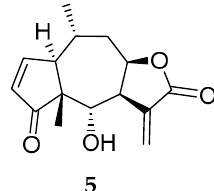
Figure 6. Structure of helenalin ( 5 ).